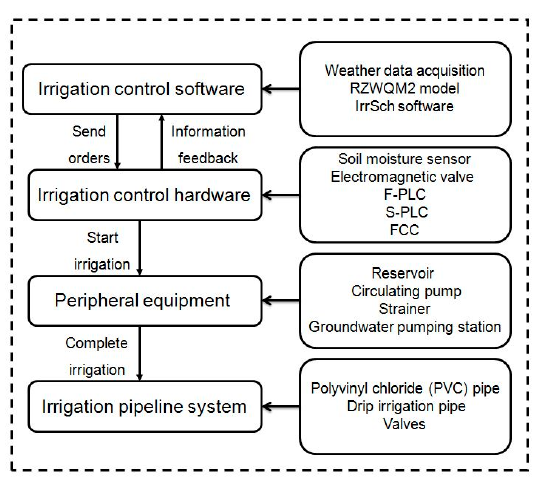
Figure 1. The Decision Support System for Irrigation Scheduling (DSSIS) based on Root Zone Water Quality Model (RZWQM2) predicted water stress factor and weather forecasts. F-PLC, the field programmable logic controller; S-PLC, the site of programmable logic controller; FCC, frequency conversion controller.